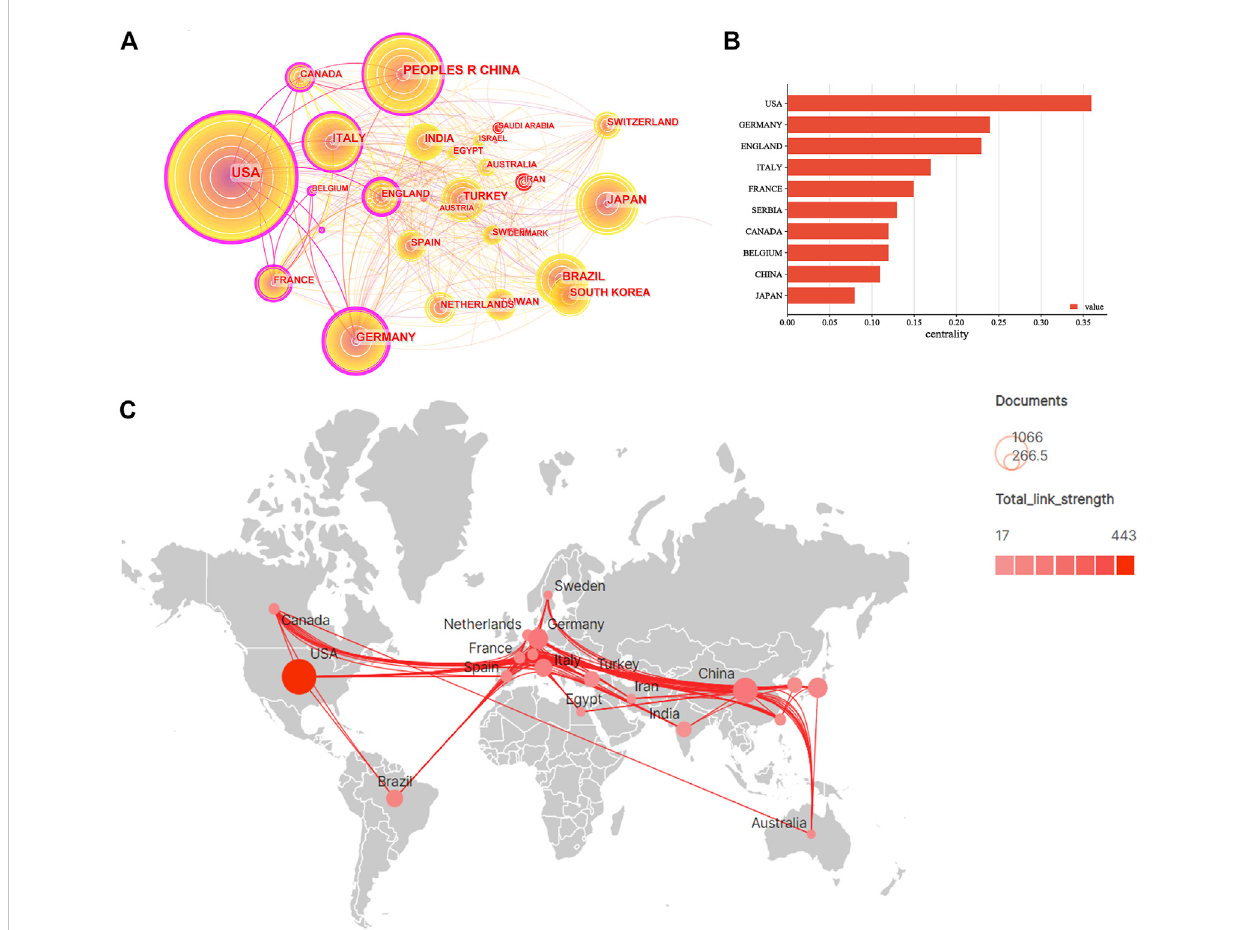
FIGURE 3 Visualizationmapofcountries/regionsinvolvedofmandibulardefectresearch. (A) CollaborationnetworkofcountriesofCiteSpace. N =92, E =388. ( N represents the number of network nodes. E represents the number of connections). (B) The centrality of countries/regions of mandibular defect research. (C) Collaborative relationships in